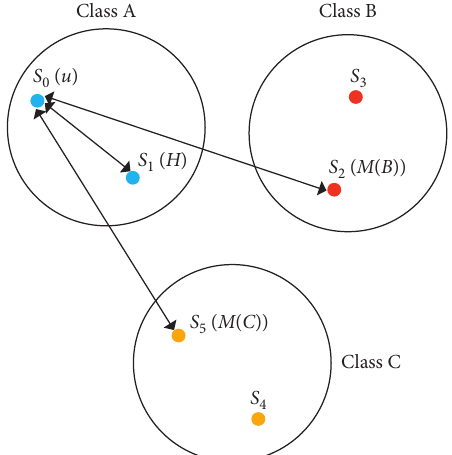
Figure 11: Finding the nearest neighbor samples (S